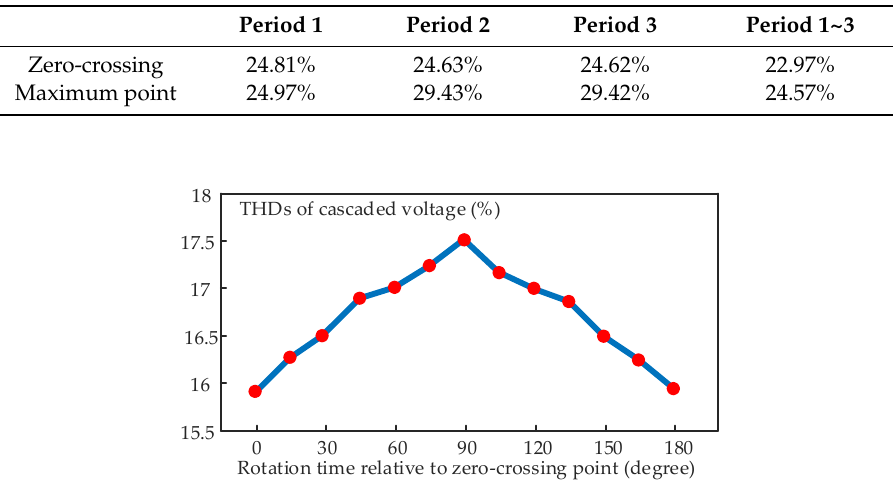
Table 2. System parameters in the experiment.